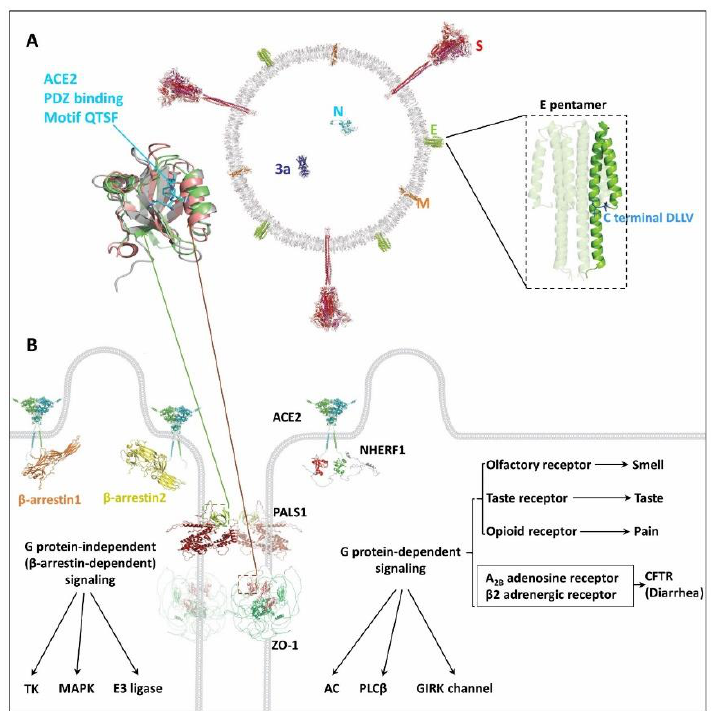
Figure 2. SARS-CoV-2 infection endangers GPCR signaling. ( A ) Intracellular or extracellular PDZ interaction enhances SARS-CoV-2 cell entry. SARS-CoV-2 contains viral proteins S, E, M, N, and ORF3a (Top middle panel). The virion ligand binds the ACE2 receptor and is internalized with the help of NHERF1 and β -arrestin. The virion can also cross the cellular barrier through leaky paracellular pathways. NHERF1 (gray), PALS1 (lime), and ZO-1 (salmon) have a similar β -sandwich- like PDZ domain containing six β -strands flanked by two α -helices (top left panel), where the characteristic hydrophobic pocket can accommodate the PDZ binding motif such as -QTSF (top left panel, cyan sticks) from ACE2 or -DLLV in E (top right panel, light blue sticks). The pentameric structure of full-length E is built using the available envelope protein model determined by solid-state NMR (PDB code: 7K3G) [30]. PDB identification codes (ID) for all protein structures used in this figure are listed in Table 2. ( B ) Possible damaged GPCR signaling by SARS-CoV-2 infection. SARS- CoV-2 hijacks the component proteins of the GPCR signaling machinery including NHERF1 and β -arrestins. Insufficient NHERF1 for some specific GPCRs may cause dysfunctional NHERF1-related G protein-dependent signaling [31,32] that includes the activity of AC, PLC β , or GIRK channel [33] (lower right panel). Non-selective preference for β -arrestins hijacked by SARS-CoV-2 cell entry may cause uncontrolled β -arrestin-dependent signaling (lower left panel) that affects the activity of TK, MAPK, and E3 ligases [34], which consequently modifies downstream